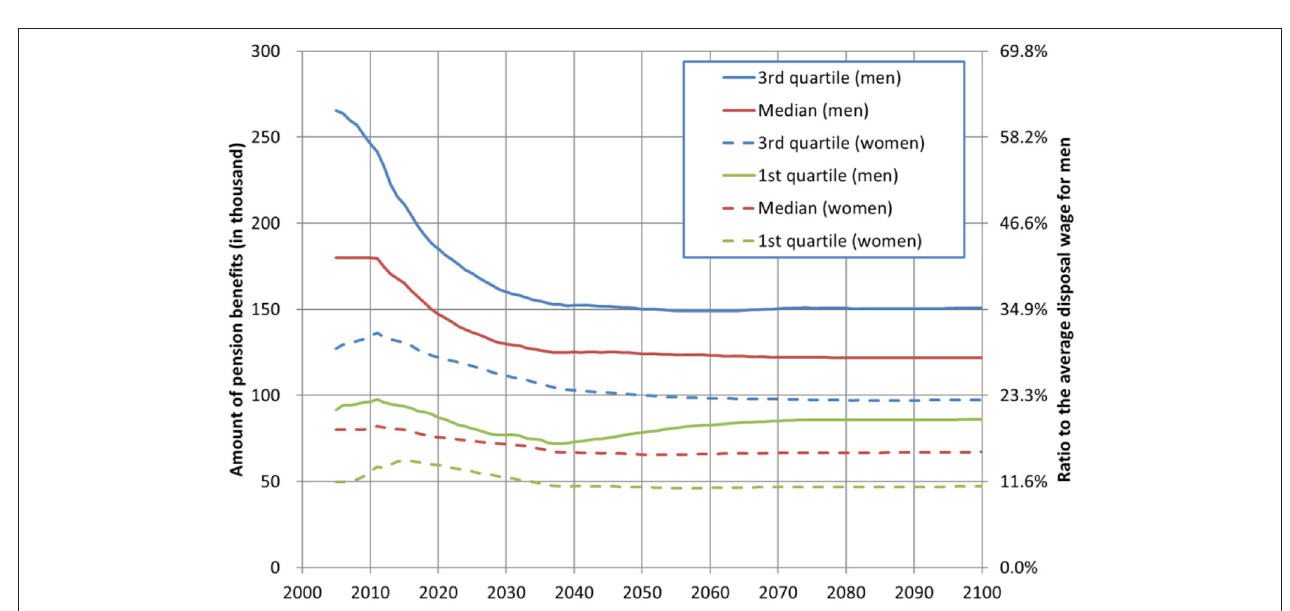
FIGURE 5 | Trends in quartiles of pension amounts by gender. Simulation